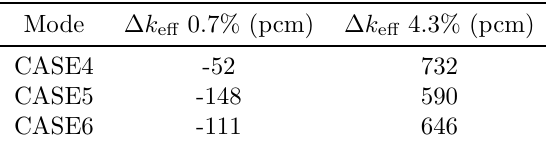
Table 6. k eff relative difference between SCALE and PARCS with 56 groups calculation and